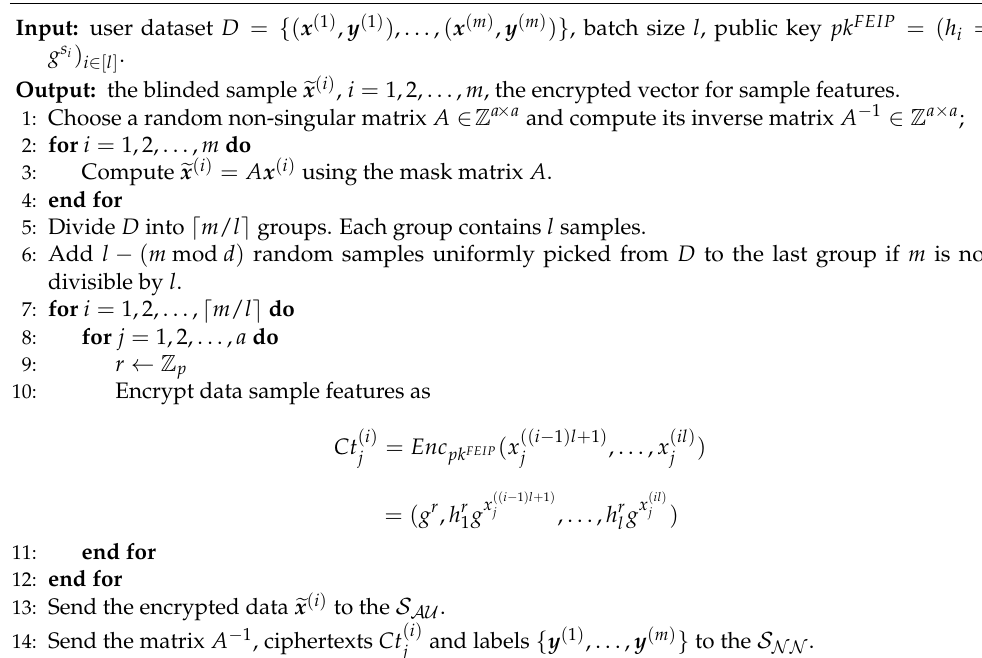
Algorithm 1 User data encryption and